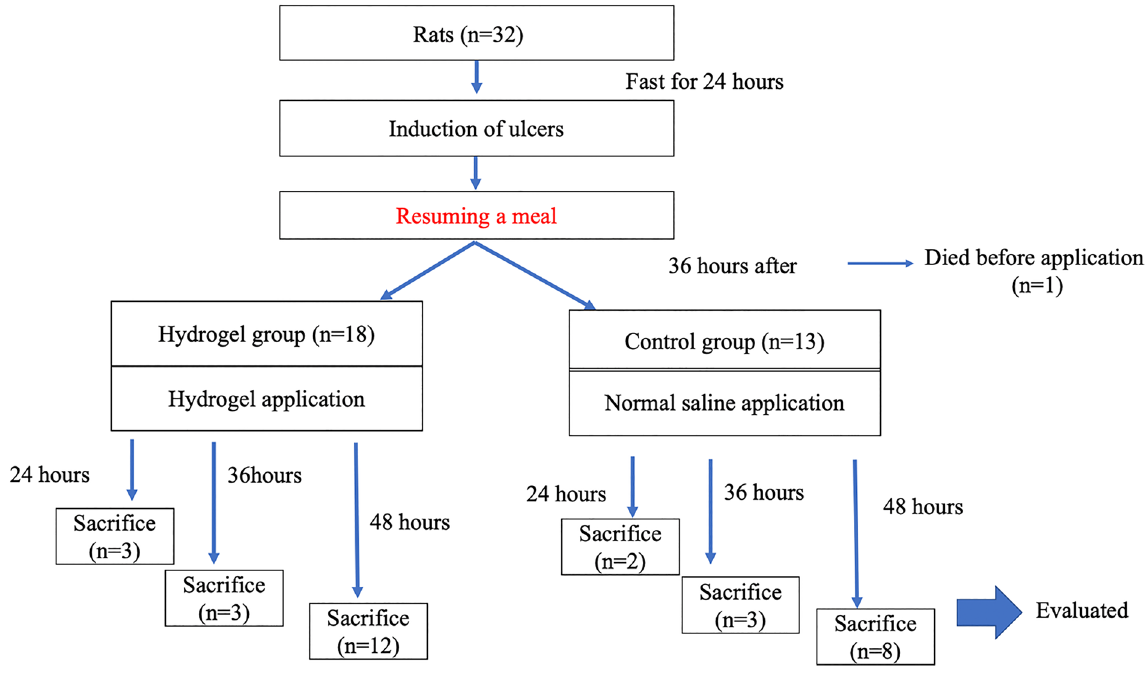
Figure 1. Flowchart of the present